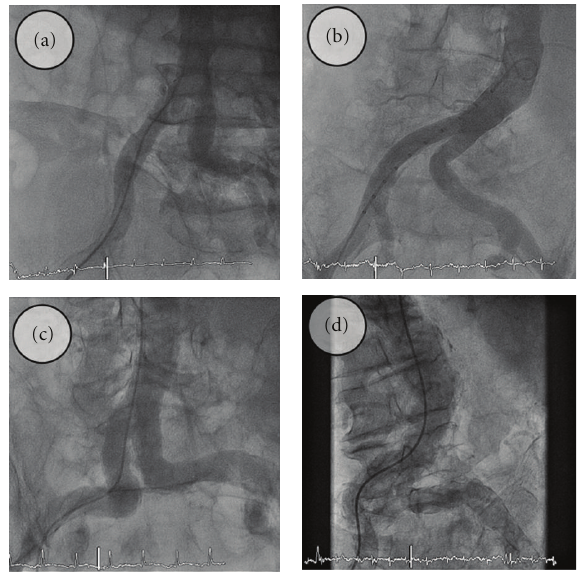
Figure 2: Examples of angiographic assessment prior to percu- taneous ventricular assist device implantation. (a)–(d). Suitable anatomy with increasing amount of calcification, plaque, and